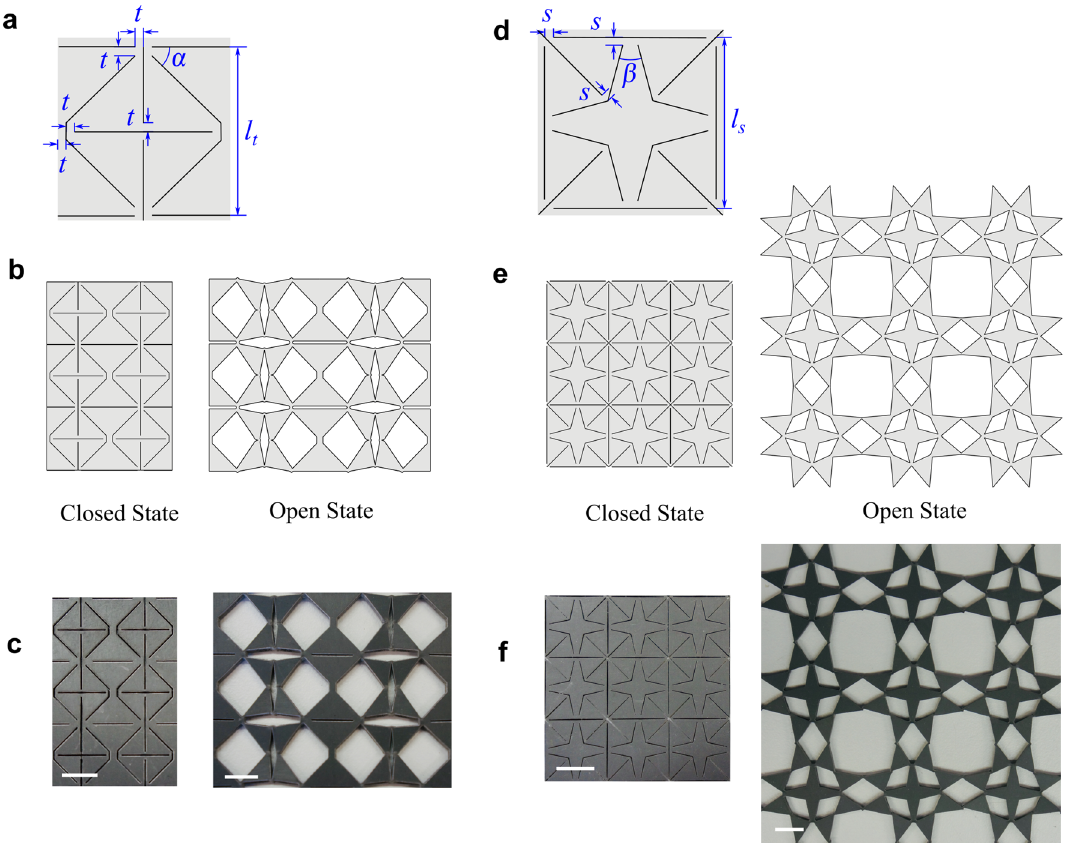
Figure 1. Metamaterial structure design. Design parameters of the unit with ( a ) triangular pattern and ( d ) star pattern. The close and open states of the tessellated ( b ) triangular metamaterial and ( e ) star metamaterial. Photograph of the laser-engraved sample with ( c ) triangular and ( d ) star patterns, in their close and open states. The length of the scale bar is 1